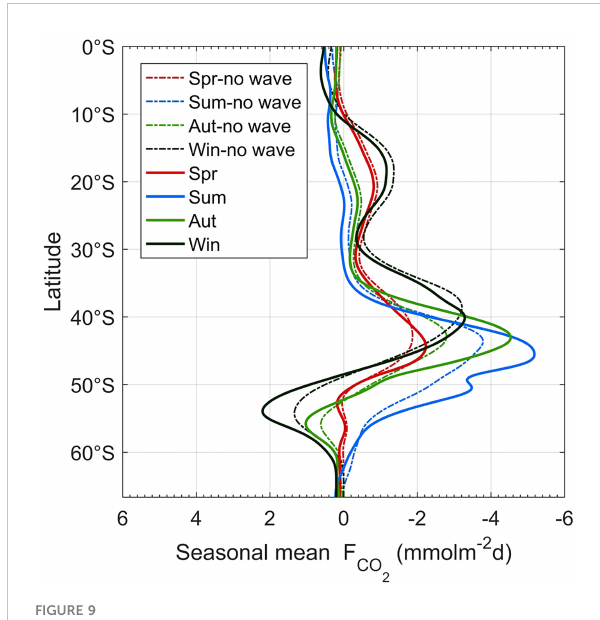
FIGURE 9 Seasonal mean zonal fl ux (mmol/m 2 ·d) from 2002 to 2021 in the Southern Indian Ocean. Dashed lines are fl ux calculated with no waves and solid lines are calculated with